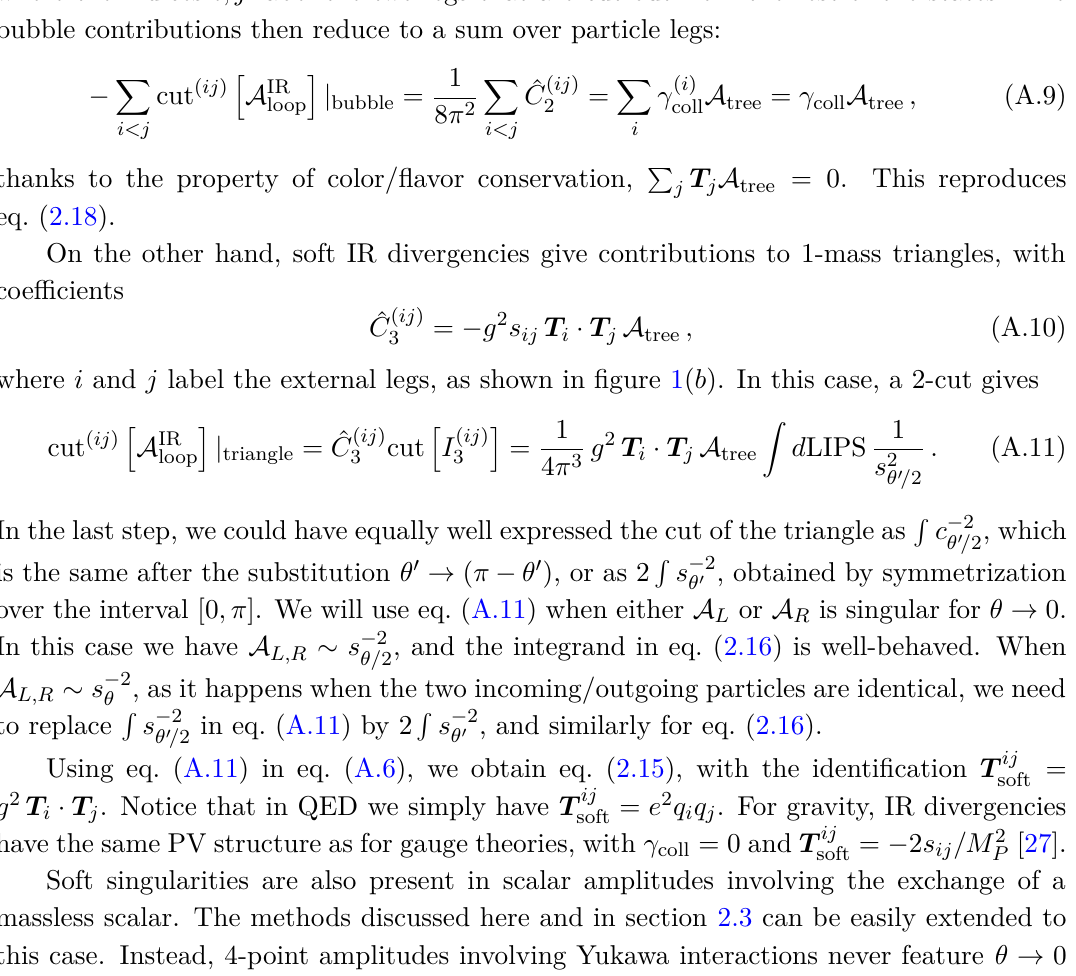
Figure 1 . Bubble (a) and triangle (b) topologies which appear in the PV decomposition of A IR in gauge and gravity